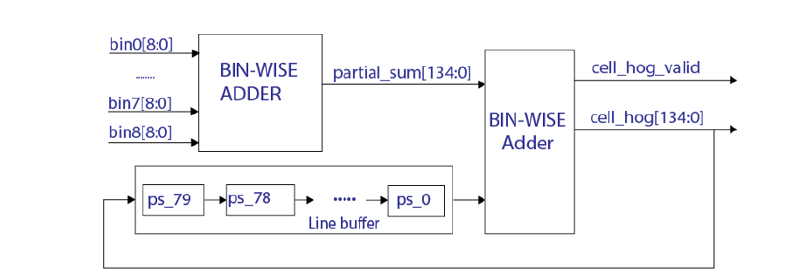
Figure 4. Pixel line buffers.